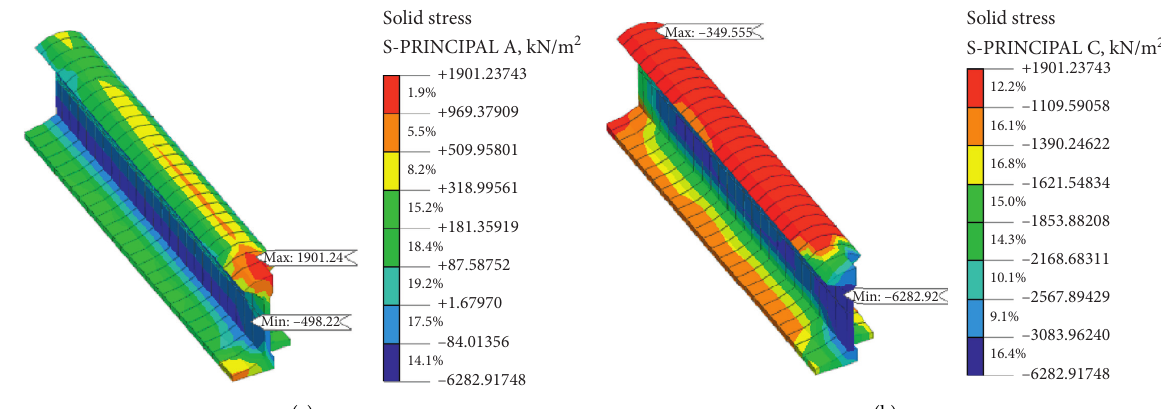
Figure 10: Maximum and minimum principal stress of mid-partition.